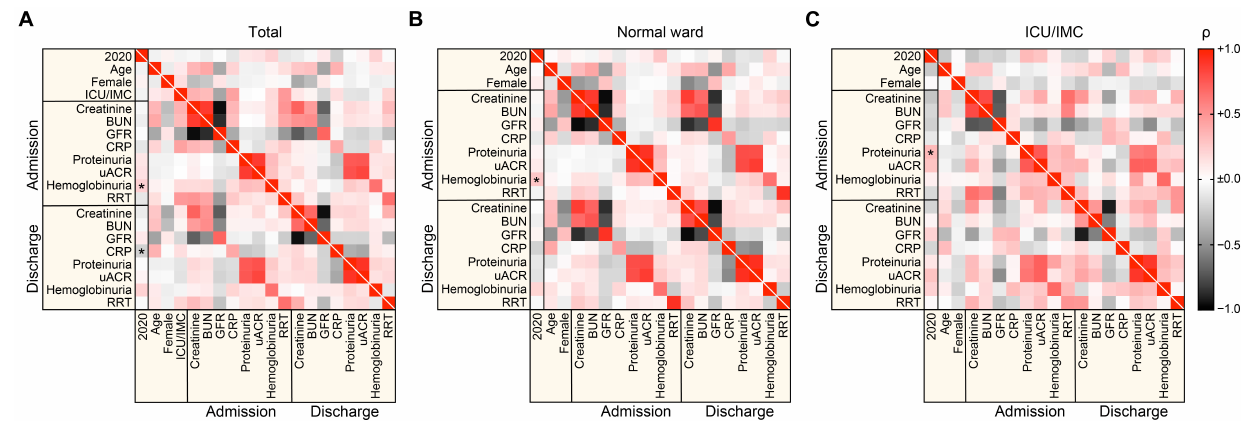
FIGURE 3 | Comparison of clinical and laboratory markers in patients requiring renal biopsy in 2019 and 2020 during the COVID-19 pandemic. (A–C) Association between renal biopsies performed in 2020 during the COVID-19 pandemic, clinical and laboratory findings at admission and discharge are shown by heatmap reflecting mean values of Spearman’s ρ , asterisks indicate p < 0.05 . BUN, blood urea nitrogen; CRP, C-reactive protein; GFR, glomerular filtration rate (CKD-EPI); ICU, intensive care unit; IMC, intermediate care unit; RRT, renal replacement therapy; uACR, urinary albumin:creatinine